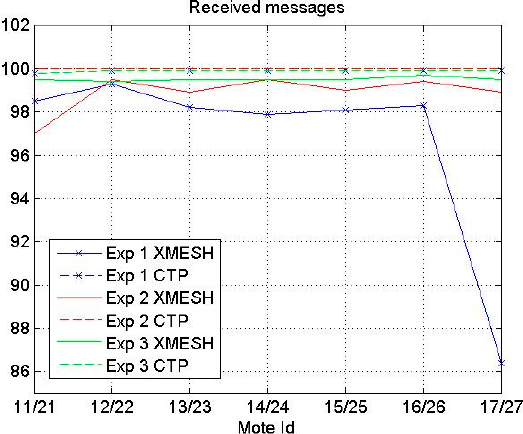
Figure 3. Percentage of received messages using the XMESH and CTP protocols.